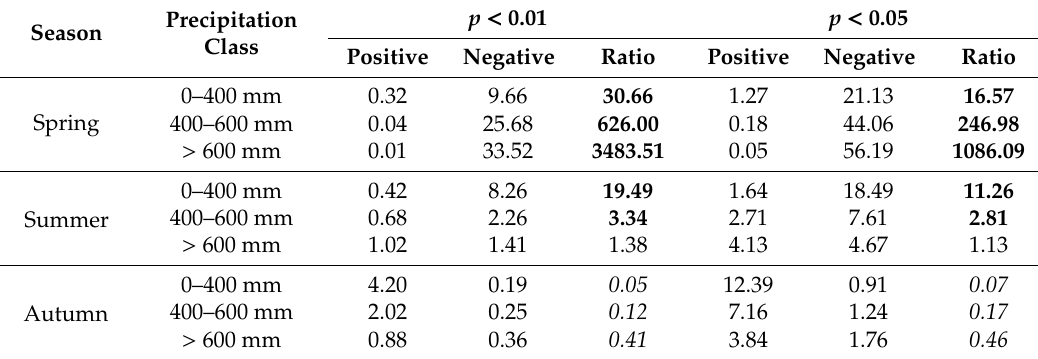
Figure 6. The correlation coe ffi cients between beginning of growing season (BGS) and net primary productivity (NPP) in spring ( a ), summer ( b ) and autumn ( c ) for di ff erent mean annual precipitation classes. Circles filled with black indicate significant correlations at p < 0.05 level. Table 3. Areal percentage of significant correlations between beginning of growing season (BGS) and seasonal net primary productivity (NPP), and the ratio of negative correlated area to positive correlated area in di ff erent precipitation classes. Ratio values in bold and in italics indicate ratio of negative correlated area to positive correlated area > 2.0 and < 0.5, respectively.